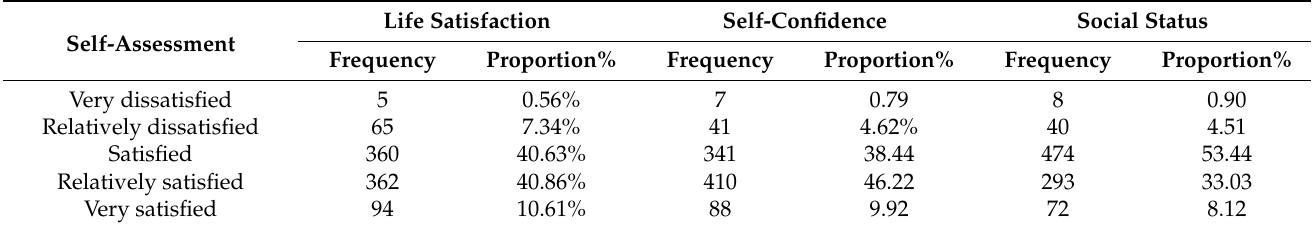
Table 1. Descriptive statistics of farmers’ sense of